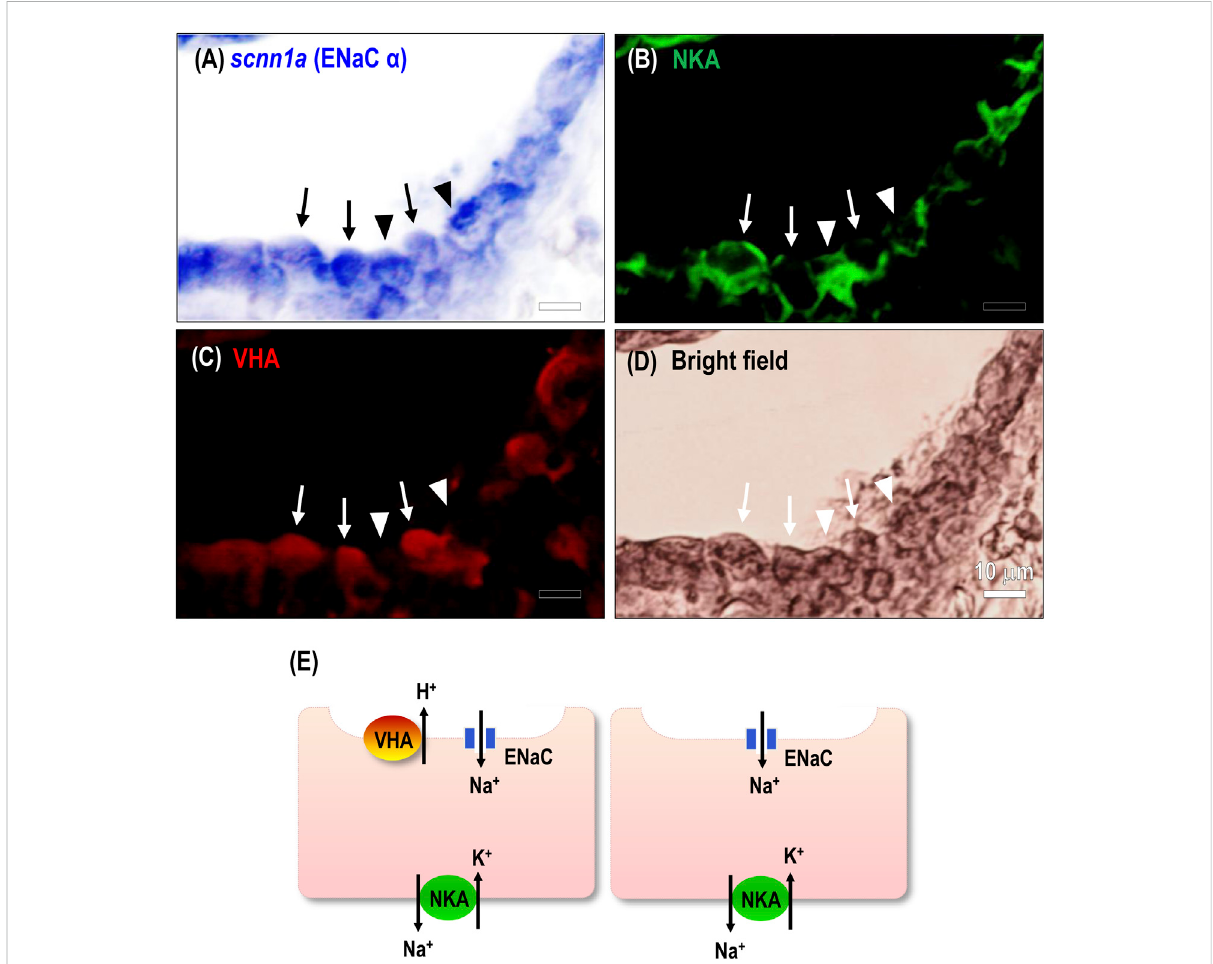
FIGURE 3 Spatial expression of ENaC in the stenohaline lamprey gills. RNA in situ hybridization ( scnn1a ) and immunocytochemical staining of Na + -K + - ATPase (NKA) and V-type H + -ATPase (VHA) was performed in gill paraf fi n sections. (A – C) , scnn1a mRNA (encoding ENaC alpha subunit) and NKA were co-localized in most gill epithelial cells; a great part of the cells showed VHA signals. Arrow, co-localization of the three transporters; arrowhead,cellwithoutapicalVHAsignal. (D) ,Bright- fi eldimageofgillcells. (E) ,Anillustrationshowsthedistributionofrelatediontransporters in gill